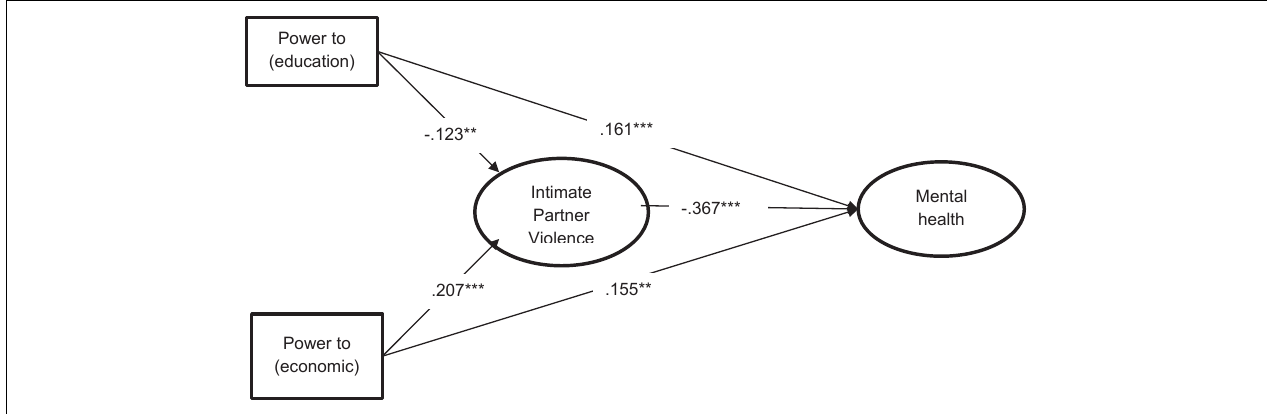
FIGURE 1 | Standardized regression coefficients for the structural regression model of our hypotheses. *** p < 0.001, ** p < 0.01; factor loadings and first-order latent variables are omitted for simplifying the interpretation.